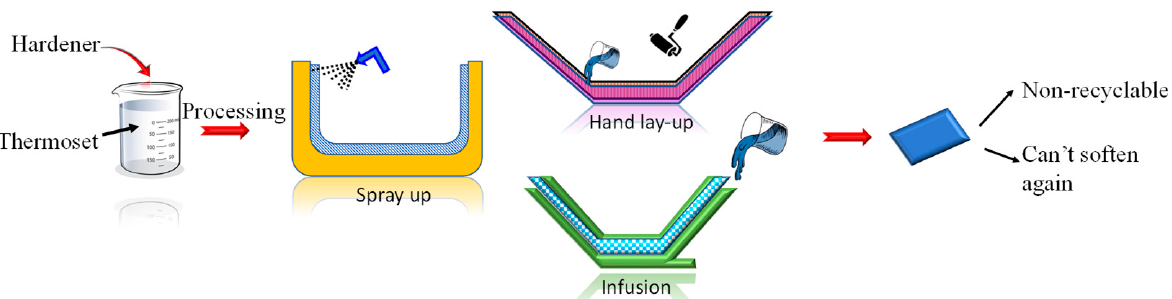
Figure 10. Thermoset matrix material in composite fabrication.